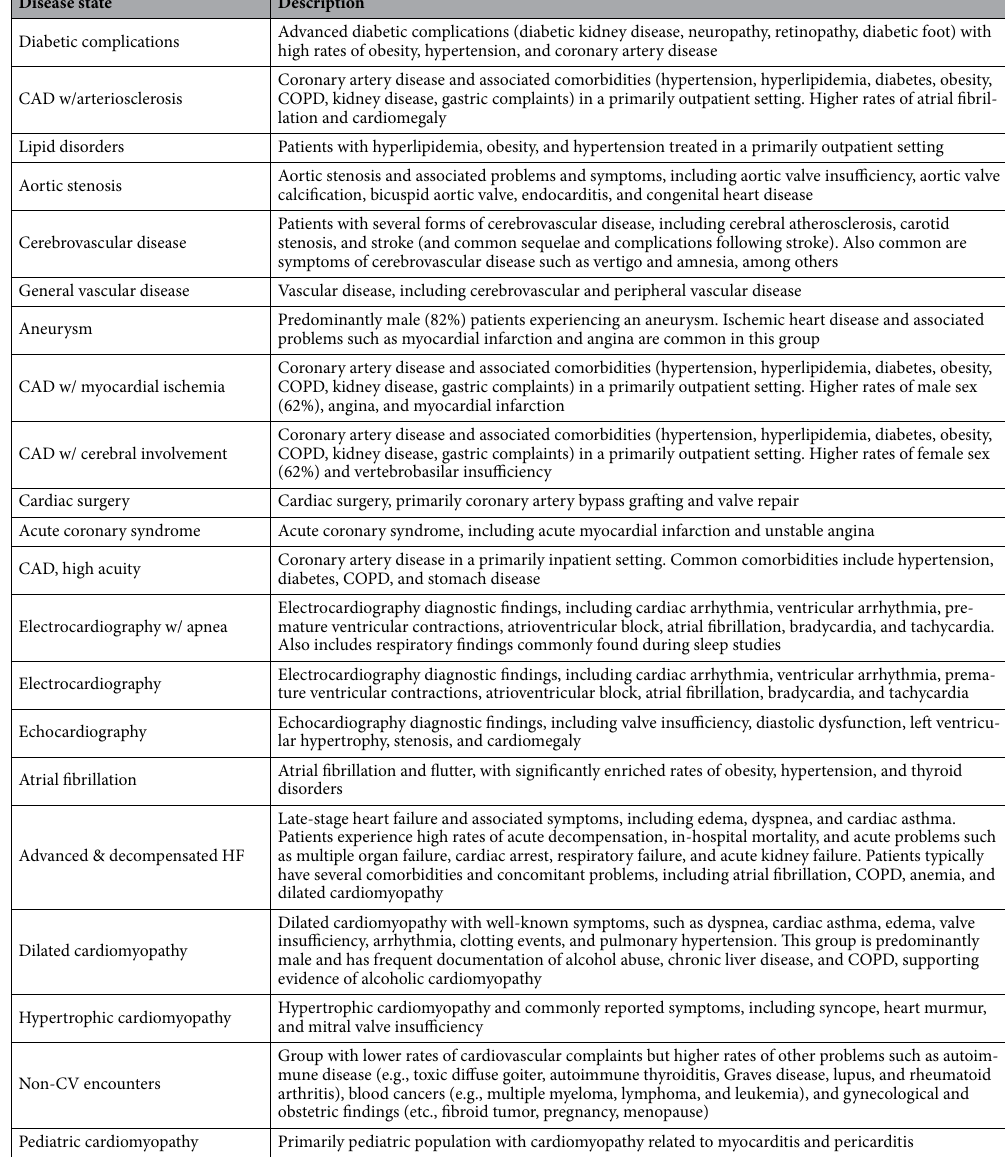
Table 3. Clinical description of heart failure disease